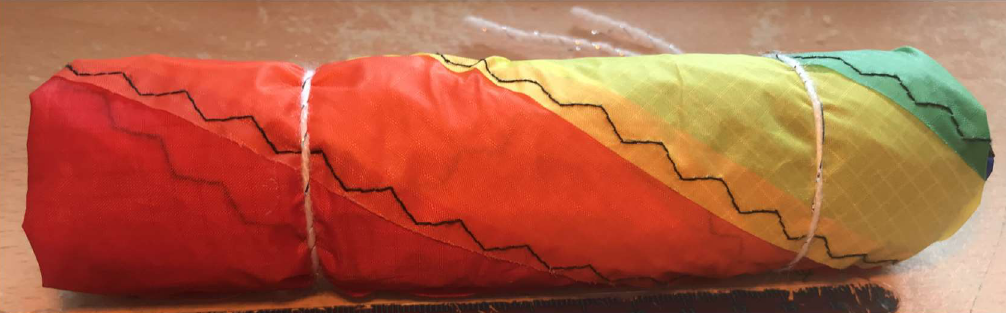
Figure 13. Packed parawing.